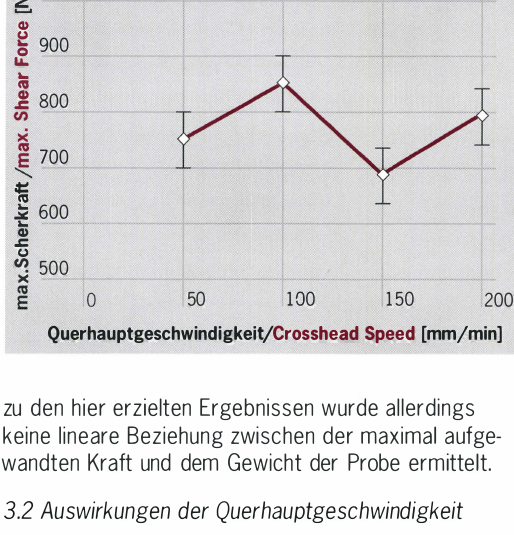
Fig. 8: Effect of crosshead speed on the maximum shear force (carrot disks, n =